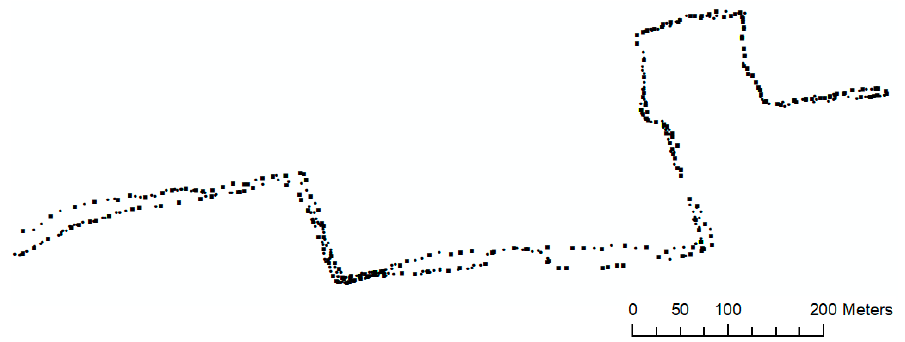
Figure 6. GPS points that shape the geometry of sidewalks (dots are clustered points (512), and squares are candidate points (267)).